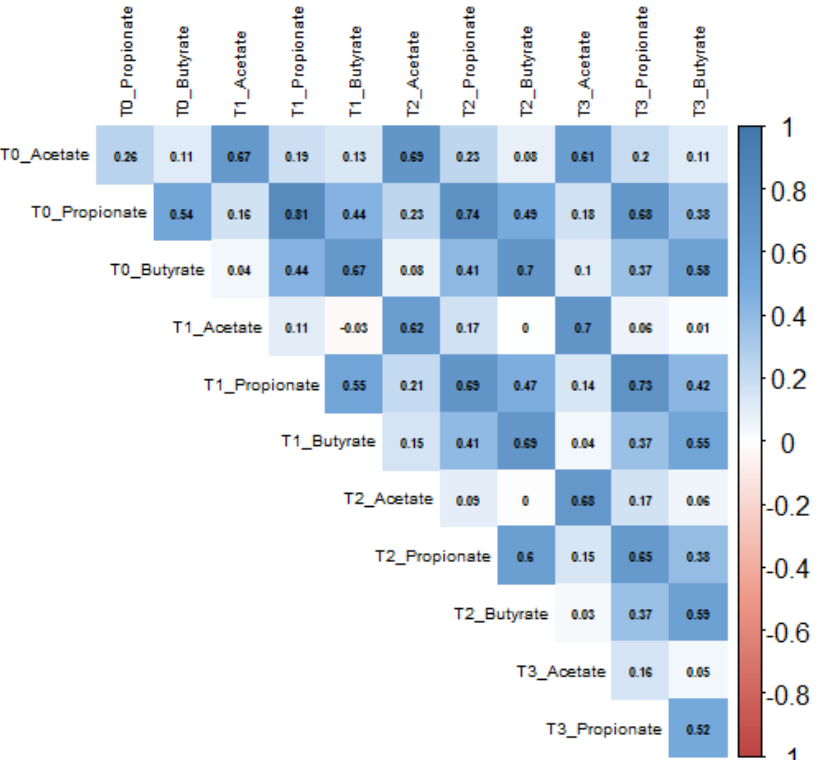
Figure 3. Intra-individual correlations between acetate, propionate, and butyrate concentrations at baseline (T0), week 12 (T1), 24 (T2) and 50 (T3), n = 126.